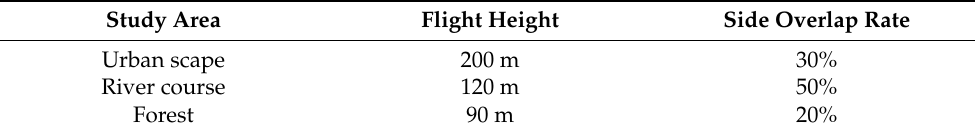
Table 2. Flight parameters of different study areas.